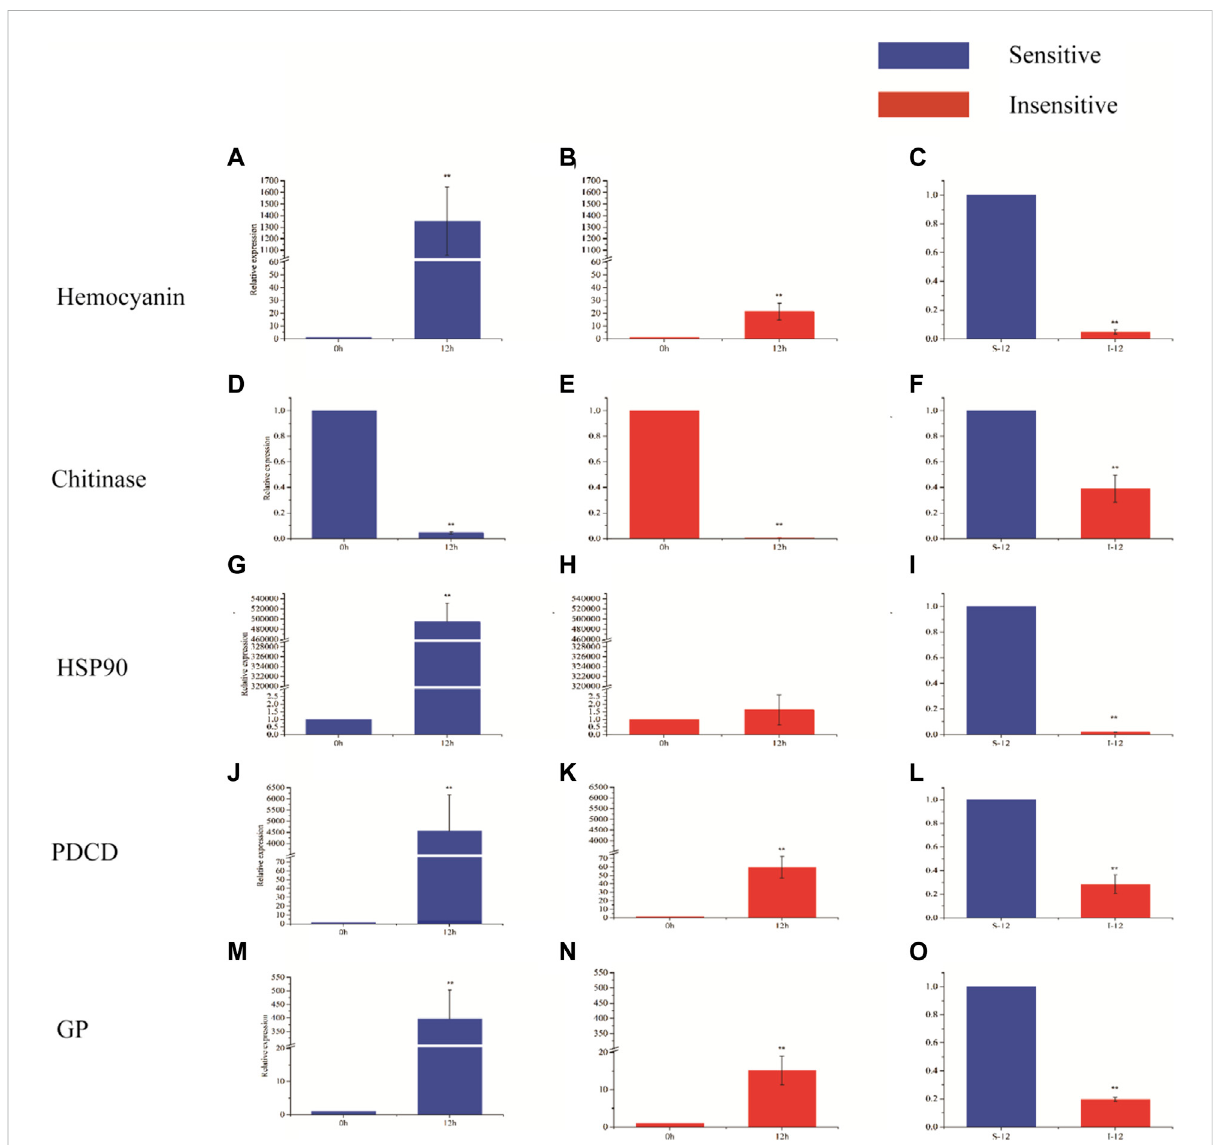
FIGURE 5 Expression of fi ve genes in different periods of hypoxia in two strains of L. vannamei . X -axis displays the KOG term, y -axis displays the corresponding protein count illustrating the protein number of different